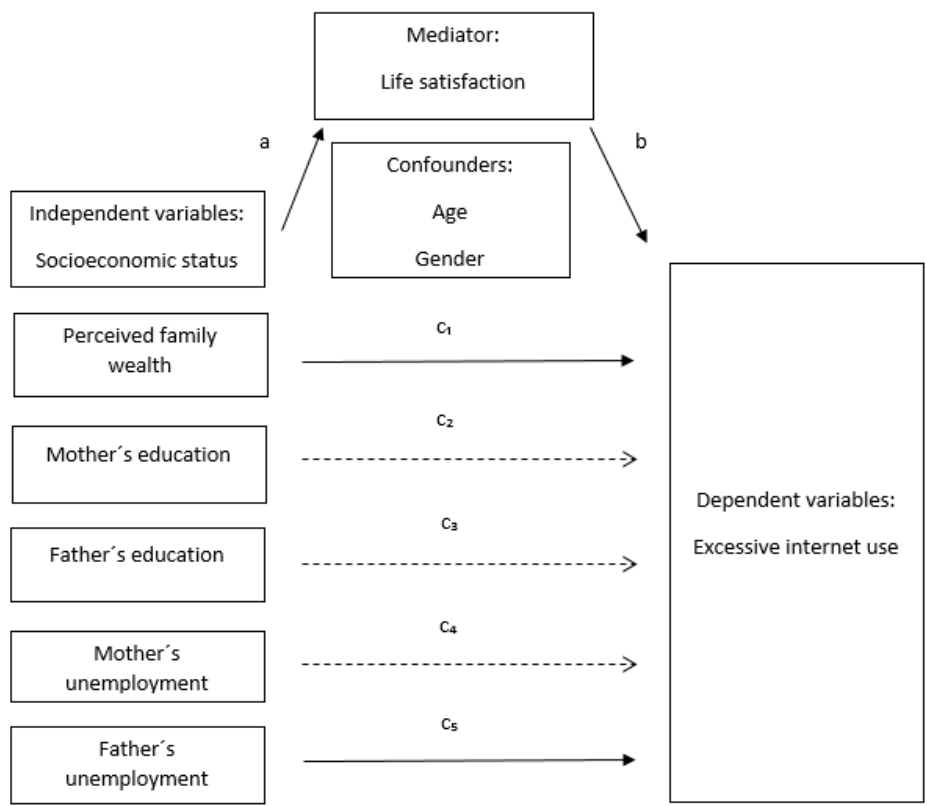
Below is a conceptual model that reflects the process of mediation confirmed in our results.